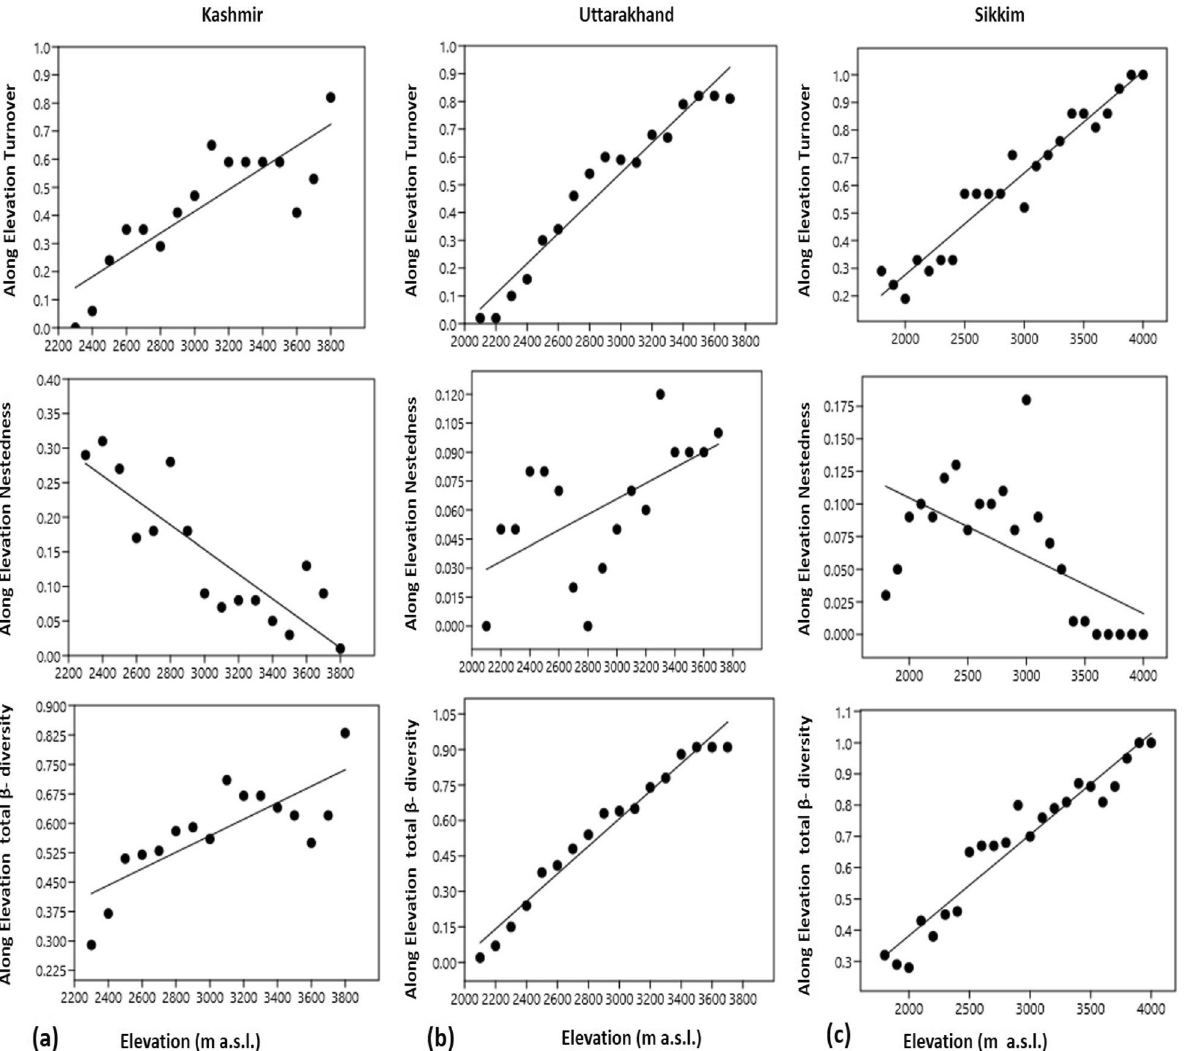
Figure 9. Turnover, nestedness and total β-diversity along the elevational transect: the effect of elevational distance on turnover, nestedness and total β-diversity was tested with a linear mixed-effects model. The line indicates the response of turnover, nestedness and overall β-diversity to elevational distance and the points display their values of pair-wise